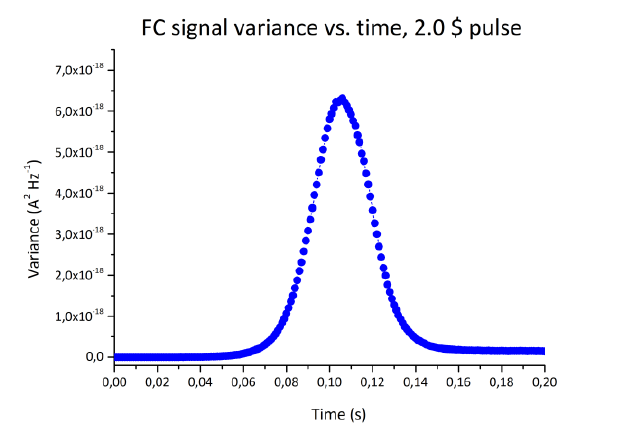
Fig. 5. Measured FC signals during a 2$ reactor pulse. 235 U FC placed ~200mm above the core. Despite the fact that 10 µg 235 U fissile deposits were not optimal for such measurements, the preliminary tests show a very satisfactory linearity between the maximal FC signals and the measured pulse peak power, as shown in Fig. 6.